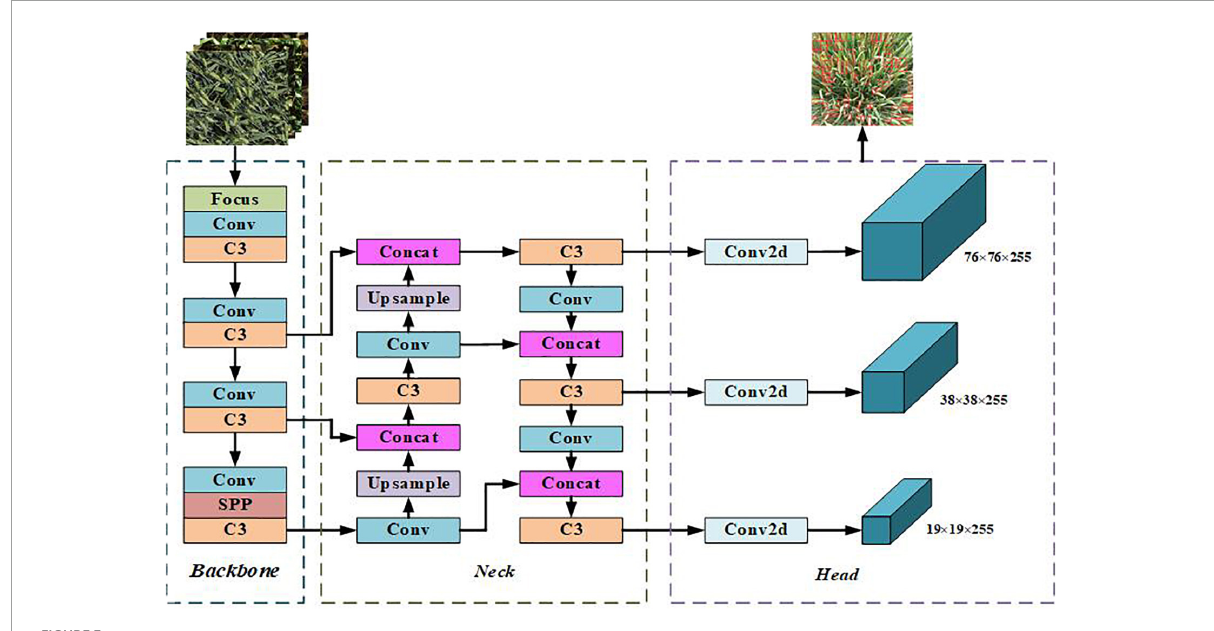
FIGURE3 Network structure of YOLOv5s